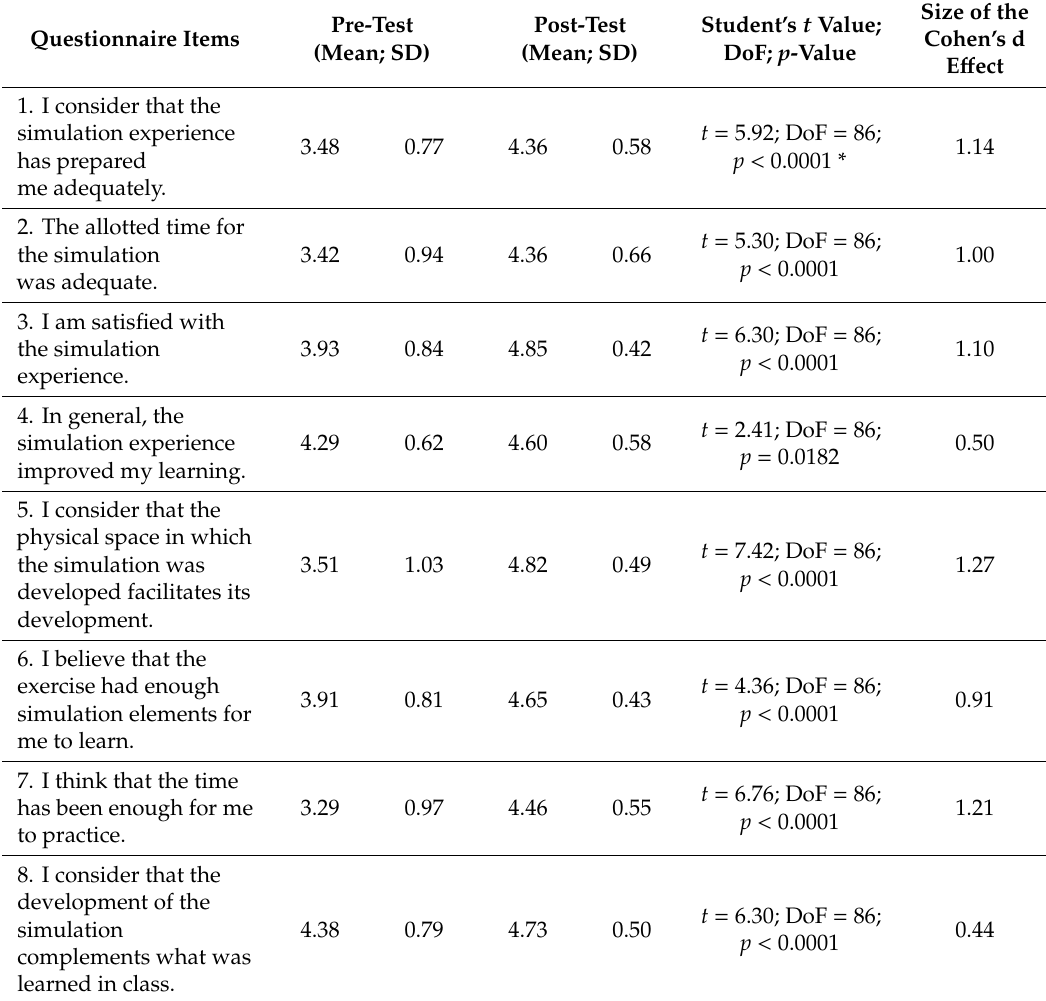
Table 1. Comparisons of the mean scores obtained in the pre-test and in the post-test. Module on